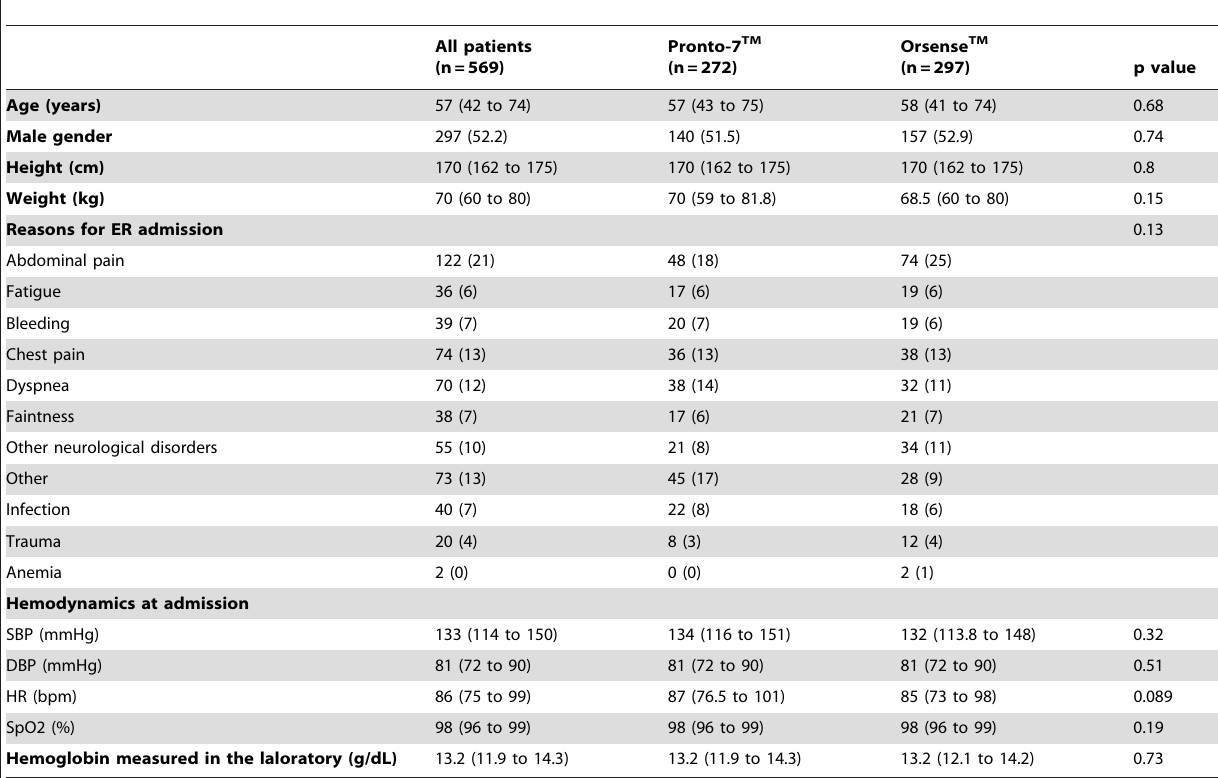
Table 1. Patient characteristics (continuous data are expressed as mean 6 SD or median [interquartile range]).